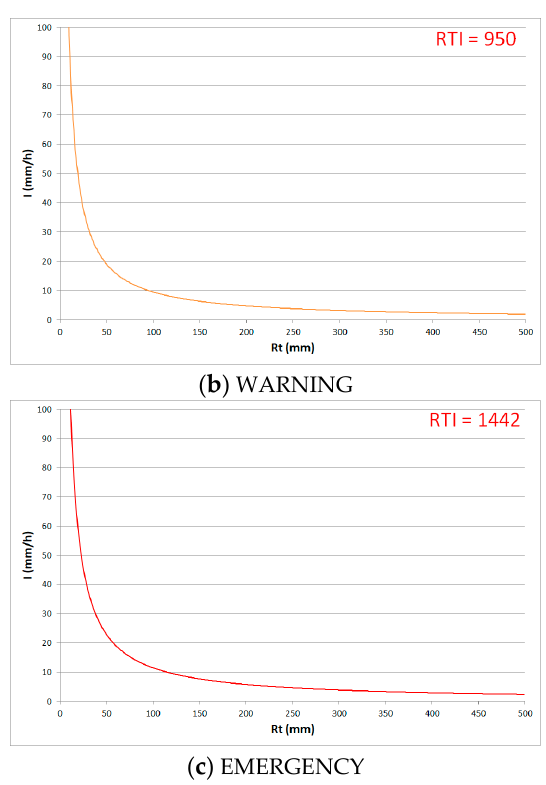
Figure 11. Estimation of rainfall triggering index (24 h): ( a ) ALERT; ( b ) WARNING; ( c ) EMERGENCY.